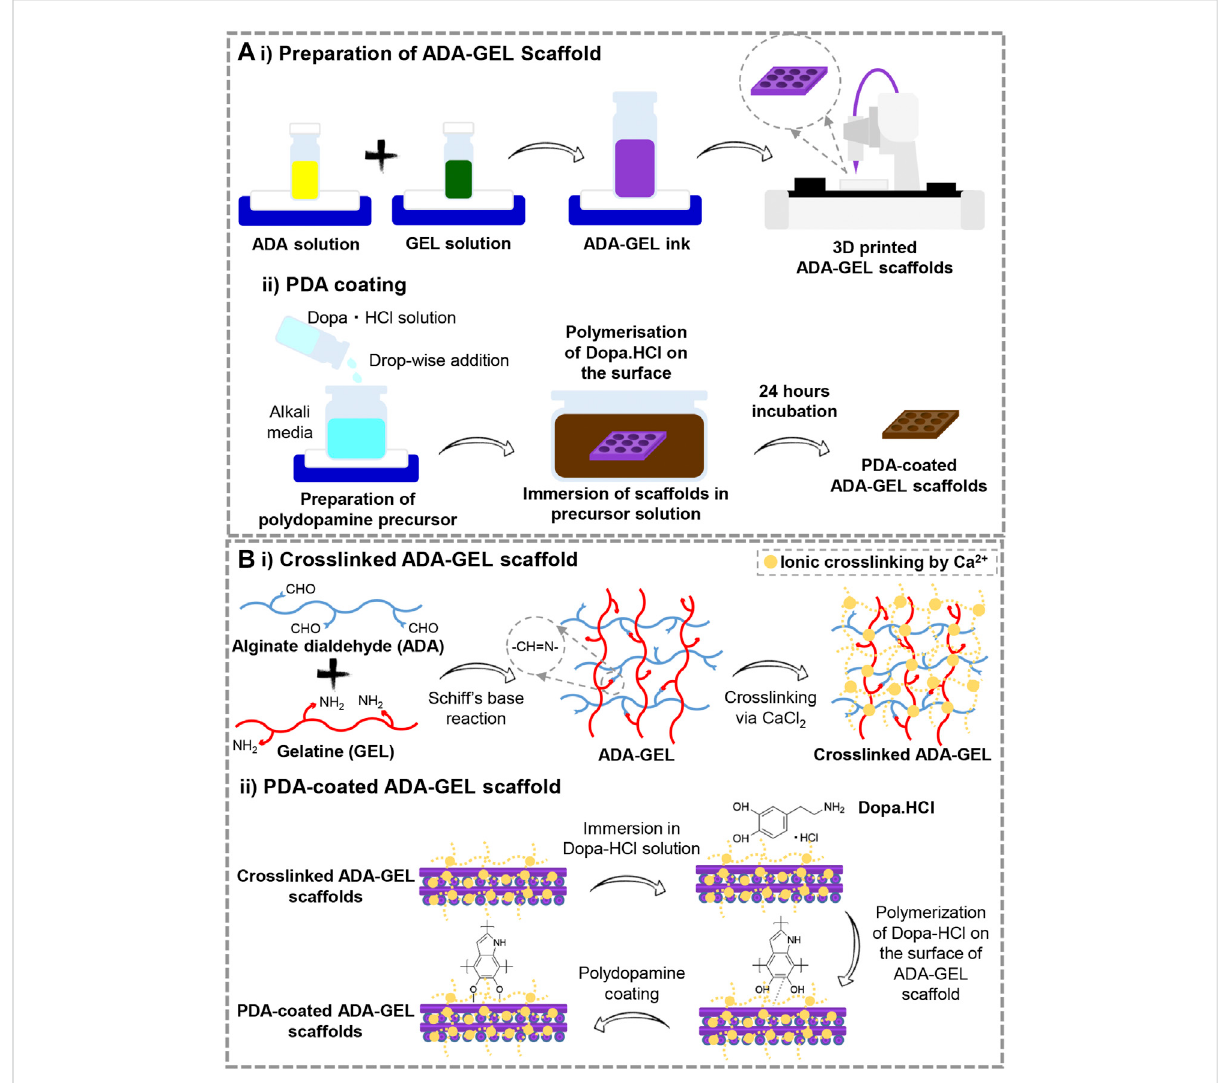
FIGURE 1 (A) Schematic illustration of the preparation steps of 1) 3D printed ADA-GEL scaffolds and 2) PDA decoration of the printed ADA-GEL scaffolds. (B) Schematic illustration of the process of 10 cross-linking and 2) PDA functionalizing ADA-GEL